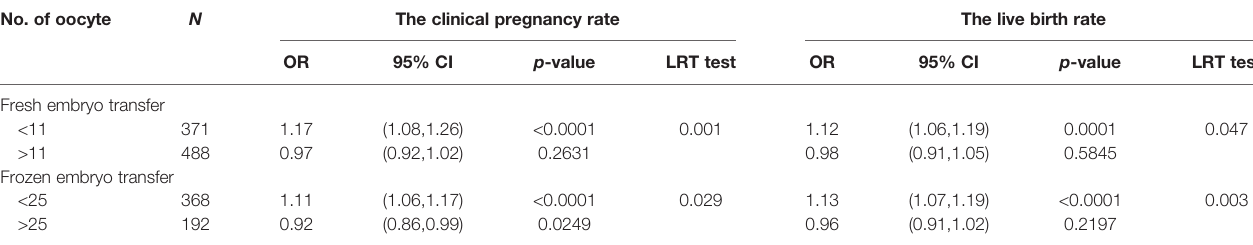
TABLE 7 | Effect of fresh/frozen embryo transfer on the association between the number of oocytes retrieved and clinical outcomes. No. of